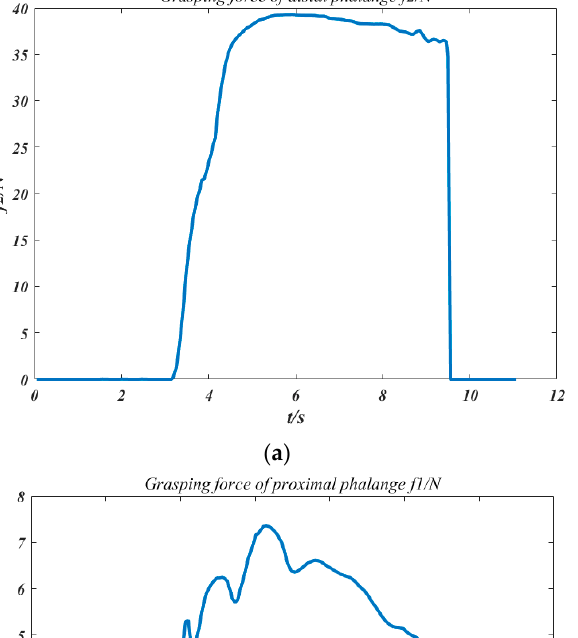
26 of 30 Figure 23. Grasping experiments scenarios: ( a ) Grasping experiment with parallel mode; ( b ) Grasp ‐ ing experiment with coupled mode; ( c ) Grasping experiment with PASA mode and COSA mode.